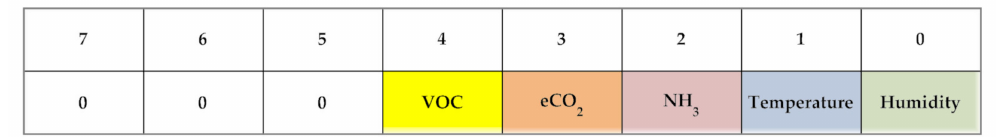
Figure 17. Structure of the warning byte transmitted from the BLE tag to signal an alarm condition related to the acquired parameters.